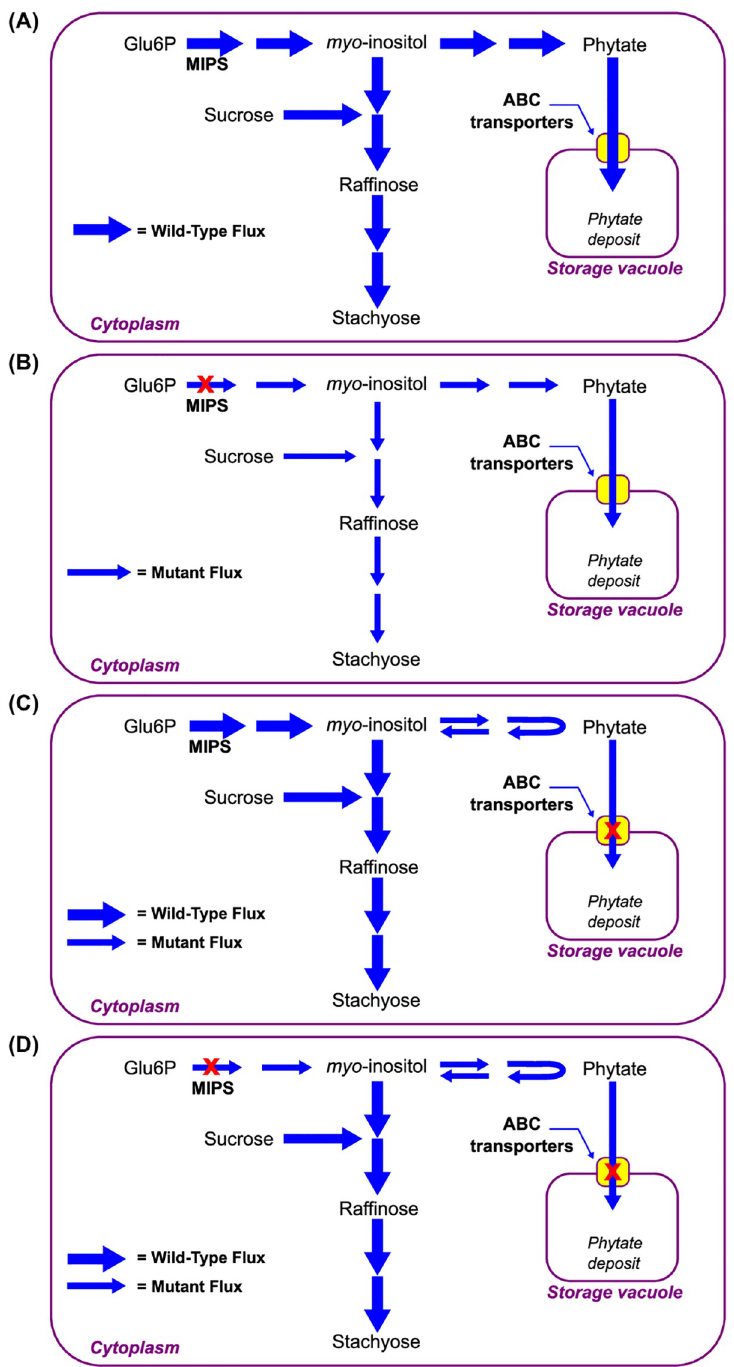
Fig 3. Interaction between the MIPS and MRP genes in V99-5089 x CX1834 recombinant inbred population. (A) Proposed model of MIPS and MRP gene interactions for seed phytate and oligosaccharide phenotypes in soybean. This model is applicable to three genotypic classes—MIPS/MRP-L/MRP-N, MIPS/ mrp-l /MRP-N, and MIPS/MRP-L/ mrp- n . (B) In V99-5089, MIPS is defective, therefore myo -inositol supply is reduced leading to low-phytate, low-RFOs, accumulation of unutilized sucrose. This model is also applicable to three genotypic classes— mips /MRP-L/MRP-N, mips / mrp-l /MRP-N, and mips /MRP-L/ mrp-n . (C) In CX1834, phytic acid transport into the protein storage vacuoles is reduced due to mutation in MRP genes, causing low-phytate. The RFO and sucrose levels are unaffected in these mutants. This model is also applicable to MIPS/ mrp-l/mrp-n genotypic class. (D) When three mutations are combined (as in mips/mrp-l/mrp-n genotypic class), lower levels of myo-inositol and phytate are being produced as a result of